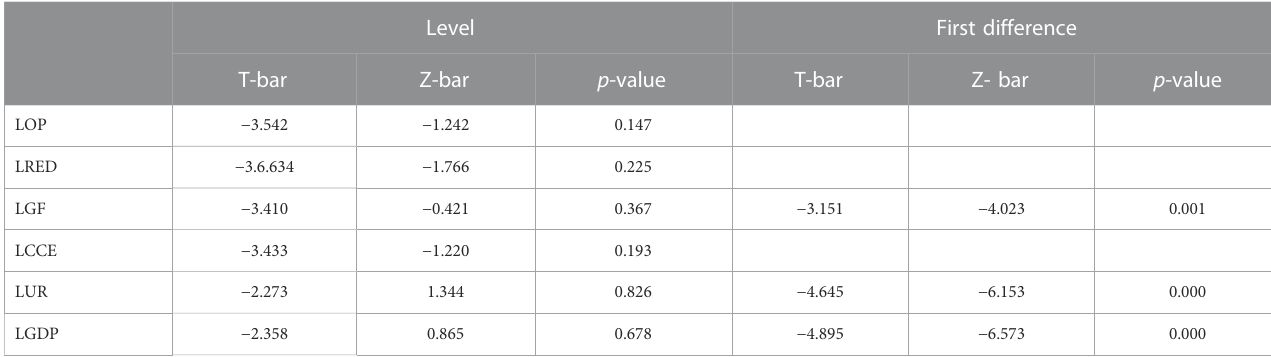
TABLE 4 Results of CADF unit root test.